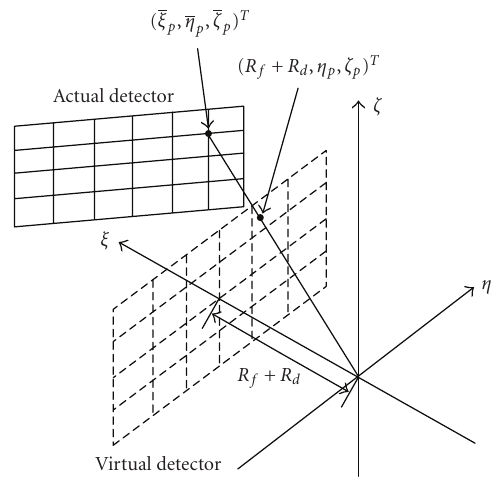
Figure 4: Illustration of the relationship between ( ¯ ζ p , ¯ η p , ¯ ξ p ) and ( R f + R d , η p , ζ p ) in coordinate system ( ζ , η , ξ